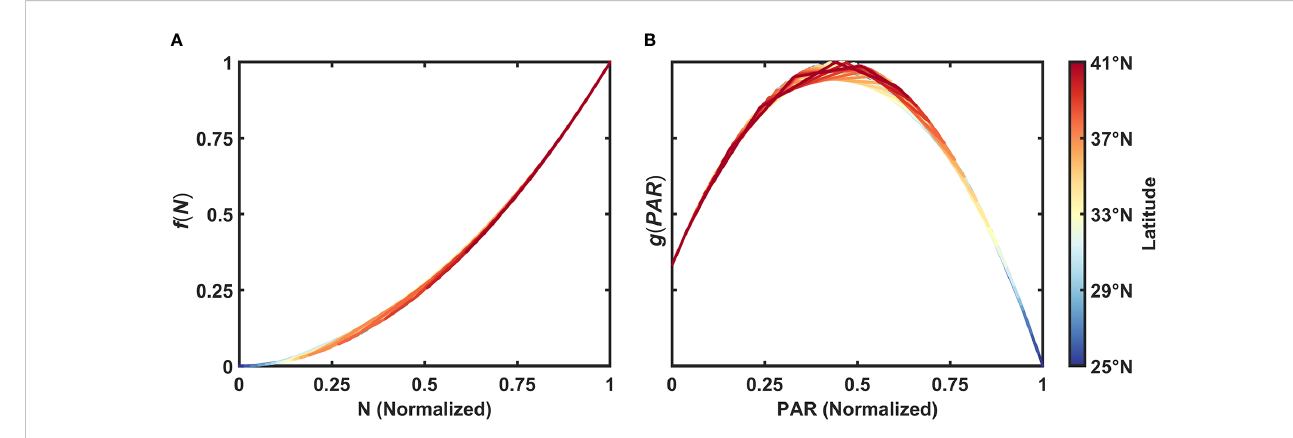
FIGURE 5 Normalized SCC responses to (A) N and (B) PAR.